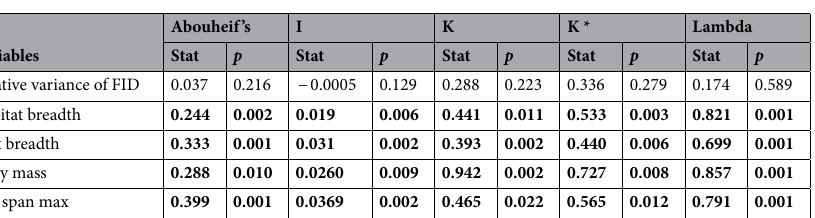
Table 1. Results of phylogenetic signal of escape behavior plasticity (coefficient of variation of FID) and other life history traits of the 95 bird species included in this study. The table shows Abouheif’s Cmean, Moran’s I, Blomberg’s K and K*, and Pagel’s Lambda statistics (Stat) and associated p values for each value. Significant variables are highlighted in bold.